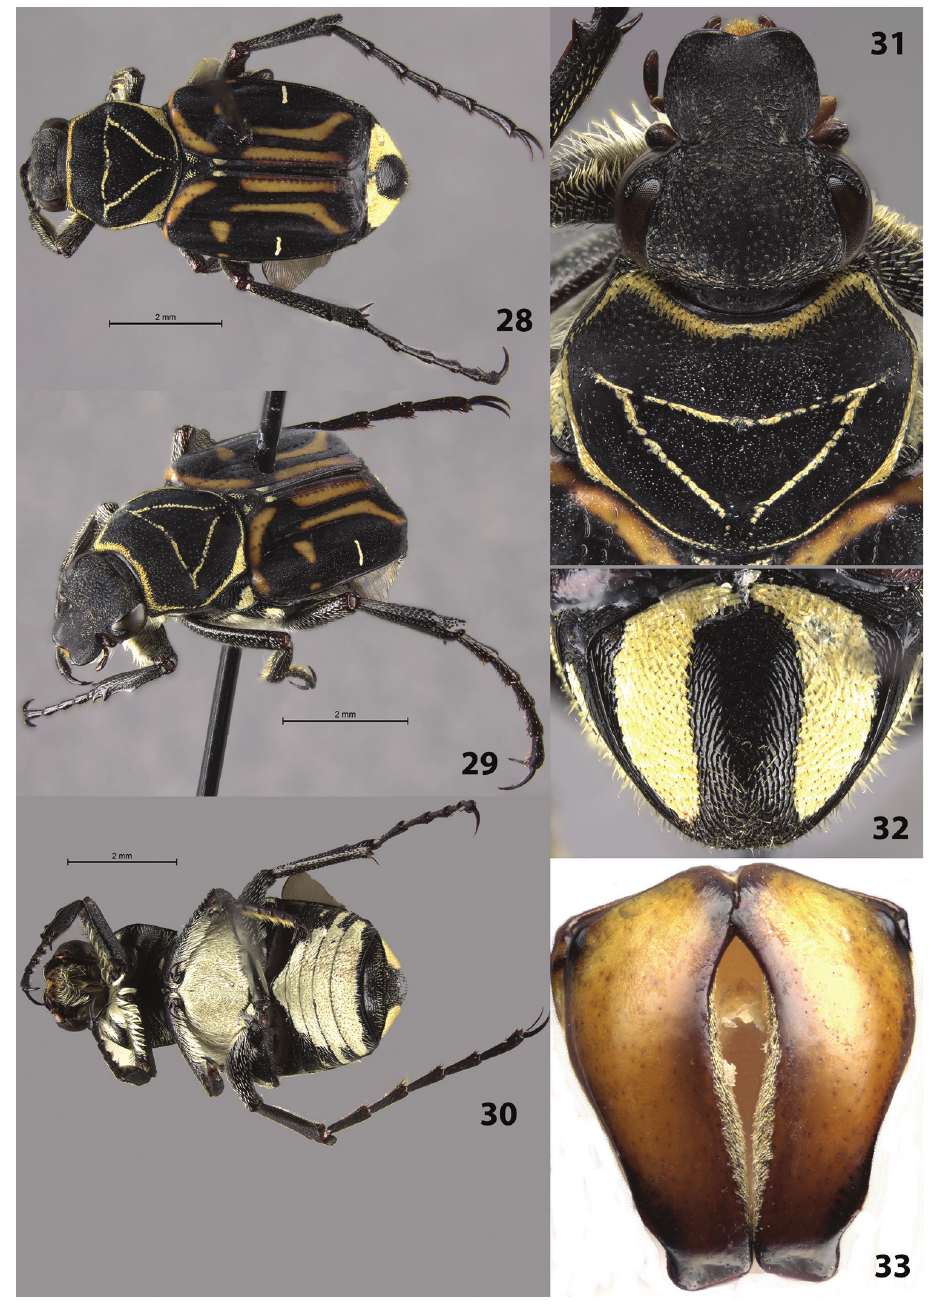
Figures 28–33. Trigonopeltastes mombachoensis sp. n., male holotype. 28 Dorsal view of habitus 29 Oblique view of habitus 30 Ventral view of habitus 31 Head and pronotum 32 Pygidium 33